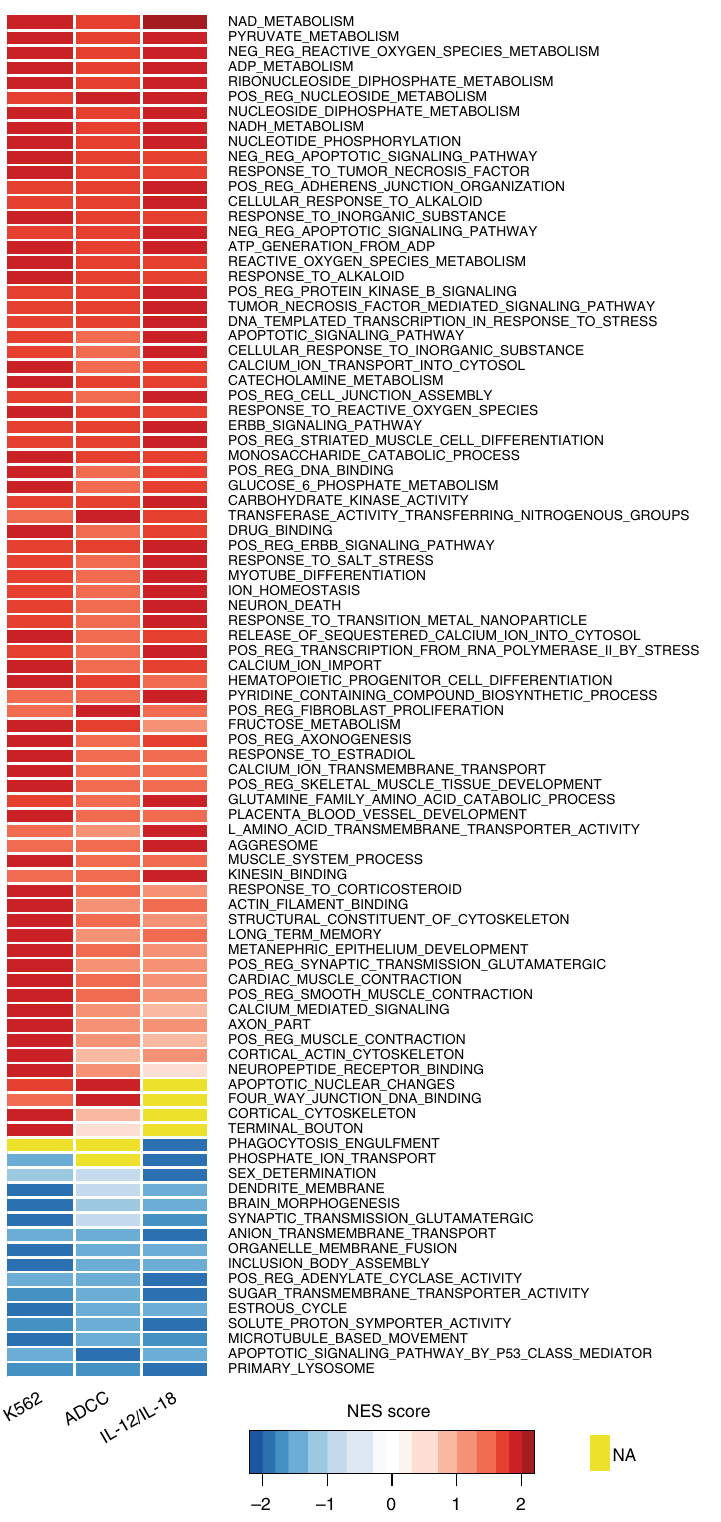
Fig. 3 Identi fi cation of Gene Ontology (GO) pathways in responding NK cells. Heat map of GO pathways involved in NK responses across stimulation conditions, ranked by sum of normalized enrichment scores (NES) in the range of 1.8> or < − 1.8. Transcriptional analysis from six healthy subjects from two independent experiments is represented. Yellow fi lled boxes indicate that the pathway was not identi fi